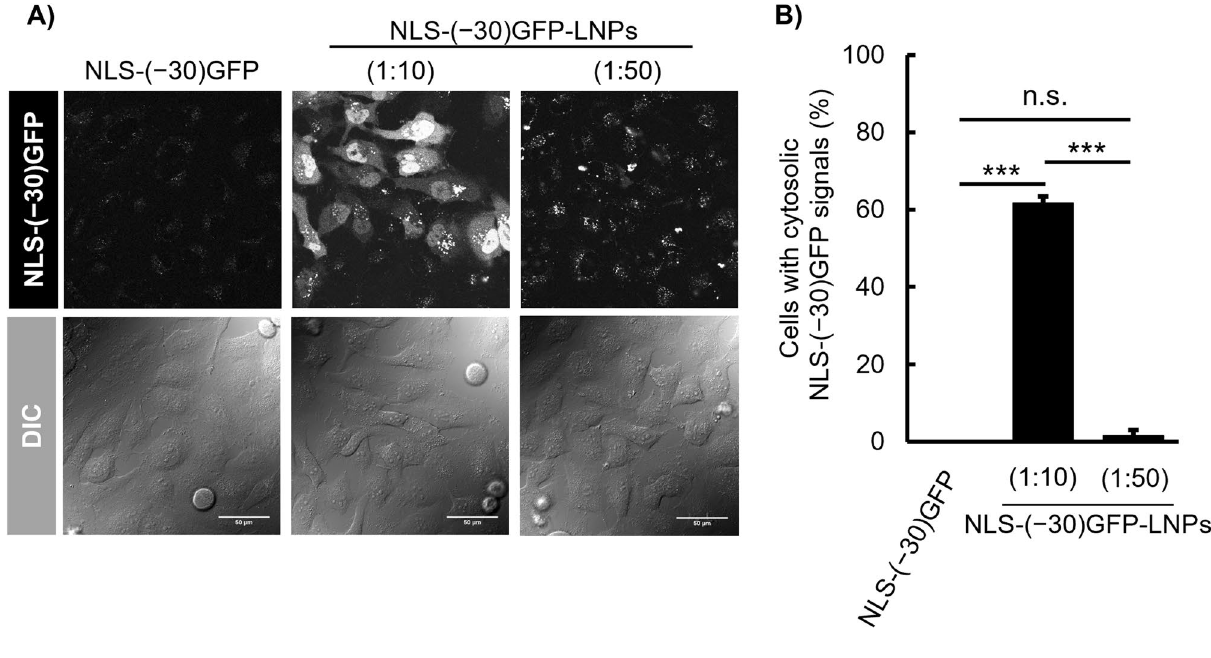
Figure 3. Cytosolic delivery of NLS-(− 30)GFP using DOP-DEDA-based LNPs. ( A ) Confocal laser scanning microscopy (CLSM) observation of the cytosolic appearance of NLS-(− 30)GFP after treatment with NLS- (− 30)GFP alone (left), NLS-(− 30)GFP-LNP (1:10) (center) and (1:50) (right) for 6 h. NLS-(− 30)GFP concentration = 2.5 μM. Scale bar, 50 μm. ( B ) Percentages of cells bearing cytosolic NLS-(− 30)GFP signals. Results are presented as mean ± standard deviation (SD) (n = 3). n.s., not significant; *** P < 0.001, (one-way analysis of variance [ANOVA] followed by Tukey–Kramer’s honestly-significant difference with DOPE [designated as NLS-(− 30)GFP-LNPs (1:10) (DOPE)] were similarly prepared; however, they had a diameter of 715 nm with a PdI 0.32, even though the LNPs contained DMG-PEG5k (1%) as a lipid component (Table S3). No significant NLS-(− 30)GFP signals were observed in the cells (Fig. 4C). We did not perform further studies to analyze the reasons for the poor NLS-(− 30)GFP delivery using the DOPE-based LNPs. However, the presence of weaker dot-like signals as seen in Fig. 4C, indicative of endosome-encapsulated NLS-(− 30)GFP, compared with the signals obtained after treatment with NLS-EGFP-LNPs (1:10) (Fig. 4A), may suggest a low endocytic efficacy due to the larger LNP size and lower encapsulation of NLS-(− 30)GFP into LNPs, suggestive of importance of pH-responsive charge-reversible characteristics of DOP-DEDA-based LNPs. Overall, the above results suggested that NLS-(–30)GFP-LNPs (1:10) was most promising in cytosolic pro- tein delivery. The encapsulation efficacy of cargo proteins in LNPs is one of the critical issues in this study. The encapsulation efficacy of NLS-(–30)GFP in NLS-(–30)GFP-LNPs (1:10) was as high as 78 ± 6% [mean ± standard deviation (SD)], n = 3) (see Supporting Information and Figure S1 for experimental details for the evaluation), further benefiting the use of DOP-DEDA-based LNP system for intracellular protein delivery.